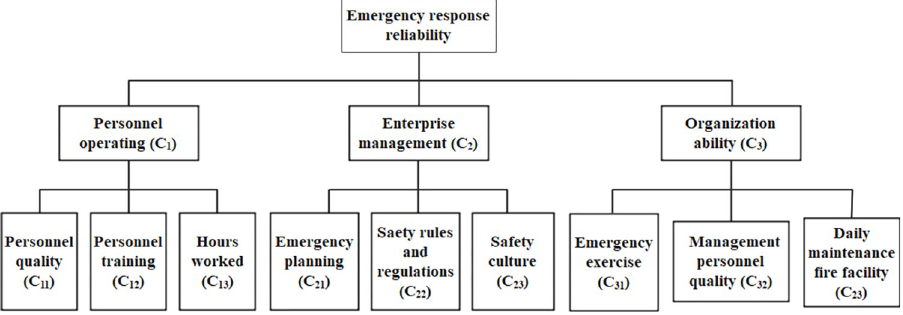
Fig 4. Hierarchical evaluation index system of the reliability of the emergency response. (a) Personnel operating